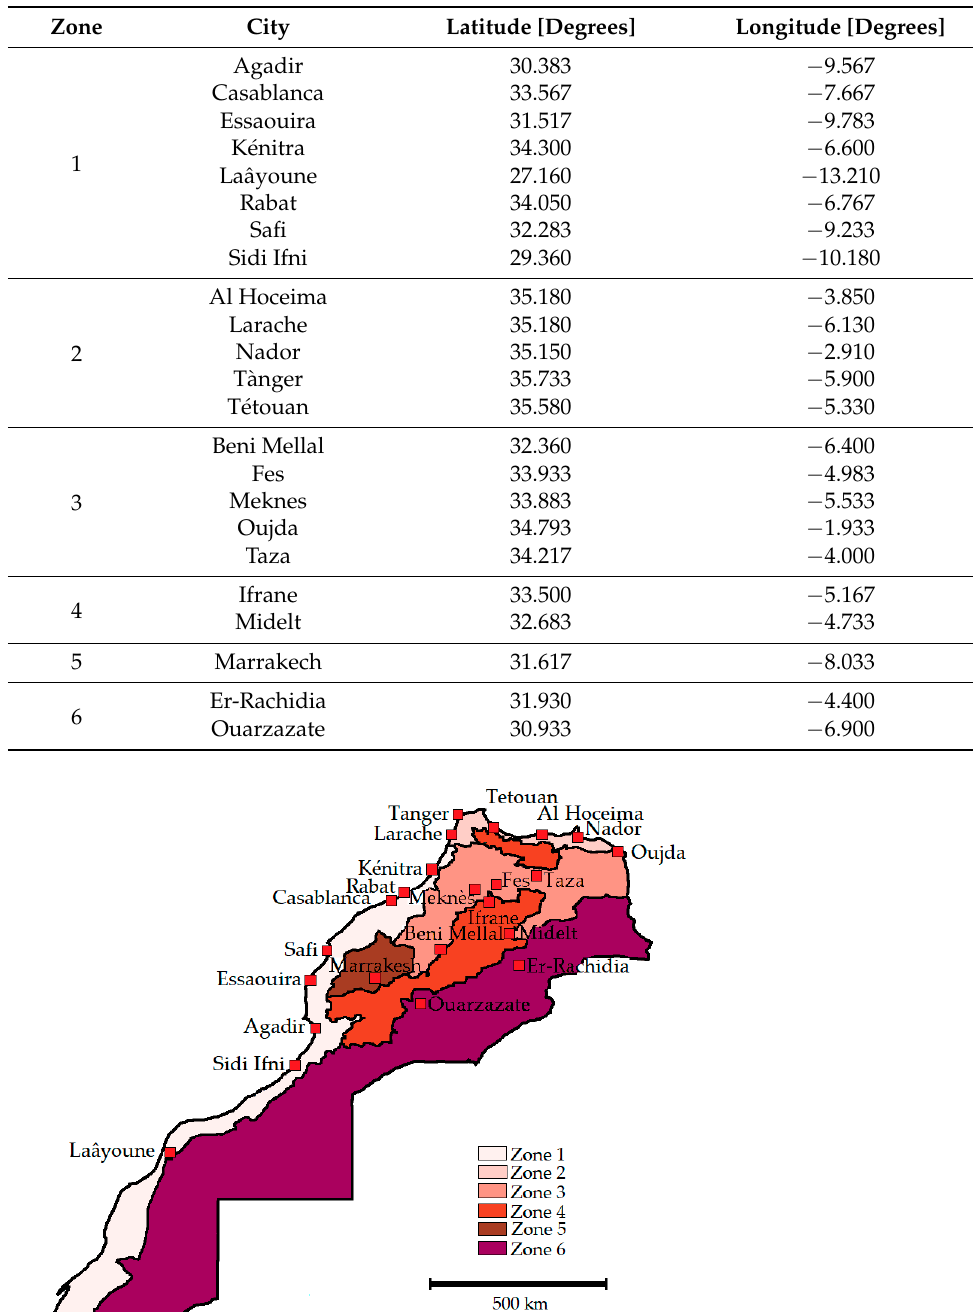
Table 2. Distribution of the analyzed cities in the different climatic zones of Morocco. Source: own elaboration based on [59,60].